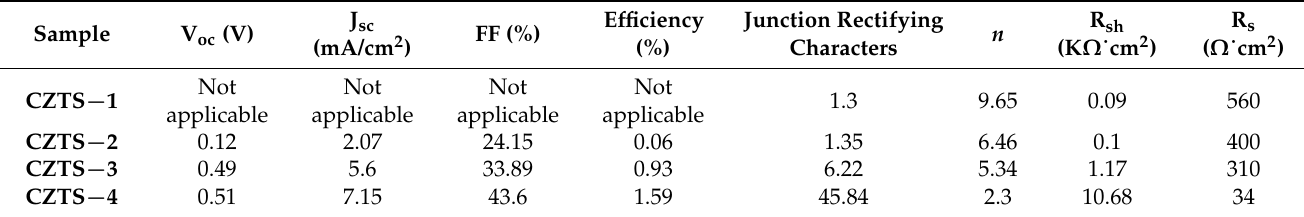
Figure 6. SIMS measurement results of CZTS − 1, CZTS − 2, CZTS − 3, and CZTS − 4.